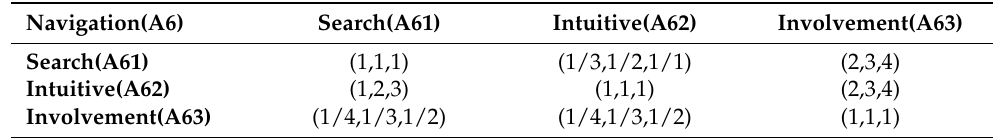
Table 10. Fuzzy-based comparison matrix associated with the sub-criteria in relation to the navigation (A6)